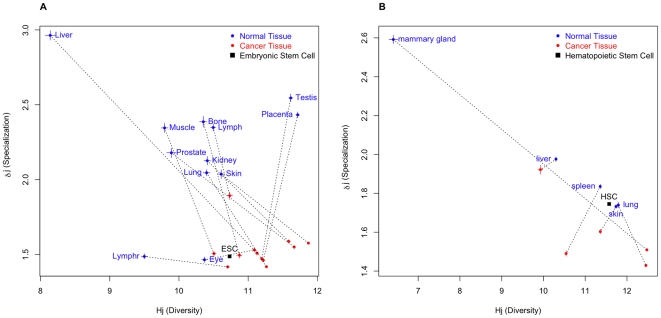
Scatter plot of Hj (Diversity) and δj (Specialization) in transcriptomes of normal tissues (blue), cancerous tissues (red), and stem cells (black).Comparable data sets are linked by a discontinuous line. A - Human data from 53 libraries of 13 distinct tissues with a total of 671,197 tags for 28,087 genes; grouped analyses. B - Mouse data from 29 libraries of 5 distinct tissues and with a total of 541,453 expressed tags for 25,044 distinct genes; grouped analyses. Data for A and B are from the “Cancer Genome Anatomy Project” (http://cgap.nci.nih.gov/). Approximate 95% confidence intervals for diversity and specialization are plotted as continuous colored lines. See Supporting Text S1 as well as Figure S1, Figure S2, Figure S3, Figure S4, Figure S5 and Figure S6 that illustrate individual comparisons and details.